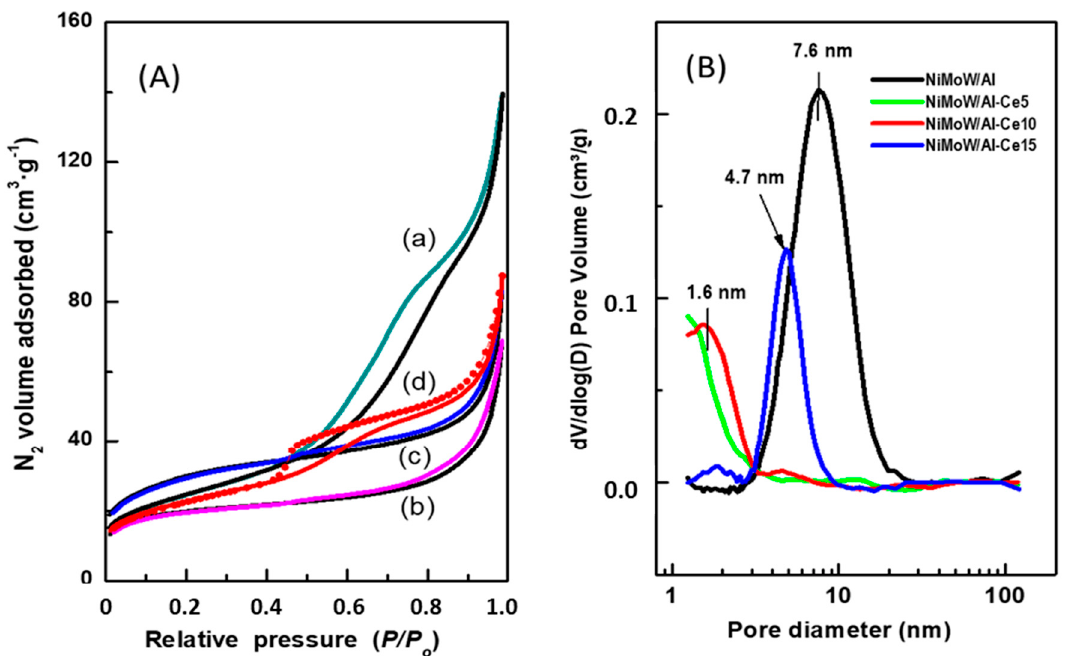
Figure 6. ( A ) N 2 adsorption-desorption isotherms of the calcined catalysts: ( a ) NiMoW/Al; Figure 6 . ( A ) N 2 adsorption ‐ desorption isotherms of the calcined catalysts: (a) NiMoW/Al; (b) Ni ‐ ( b ) NiMoW/Al-Ce5; ( c ) NiMoW/Al-Ce-10, and ( d ) NiMoW/Al-Ce-15. ( B ) Pore size distribution of MoW/Al ‐ Ce5; (c) NiMoW/Al ‐ Ce ‐ 10, and (d) NiMoW/Al ‐ Ce ‐ 15. ( B ) Pore size distribution of the cal ‐ the calcined catalysts as determined from the adsorption branch of N 2 cined catalysts as determined from the adsorption branch of N 2 isotherms . Table 3. Textural data of calcined catalysts calculated from the N 2 adsorption ‐ desorption iso ‐ therms .